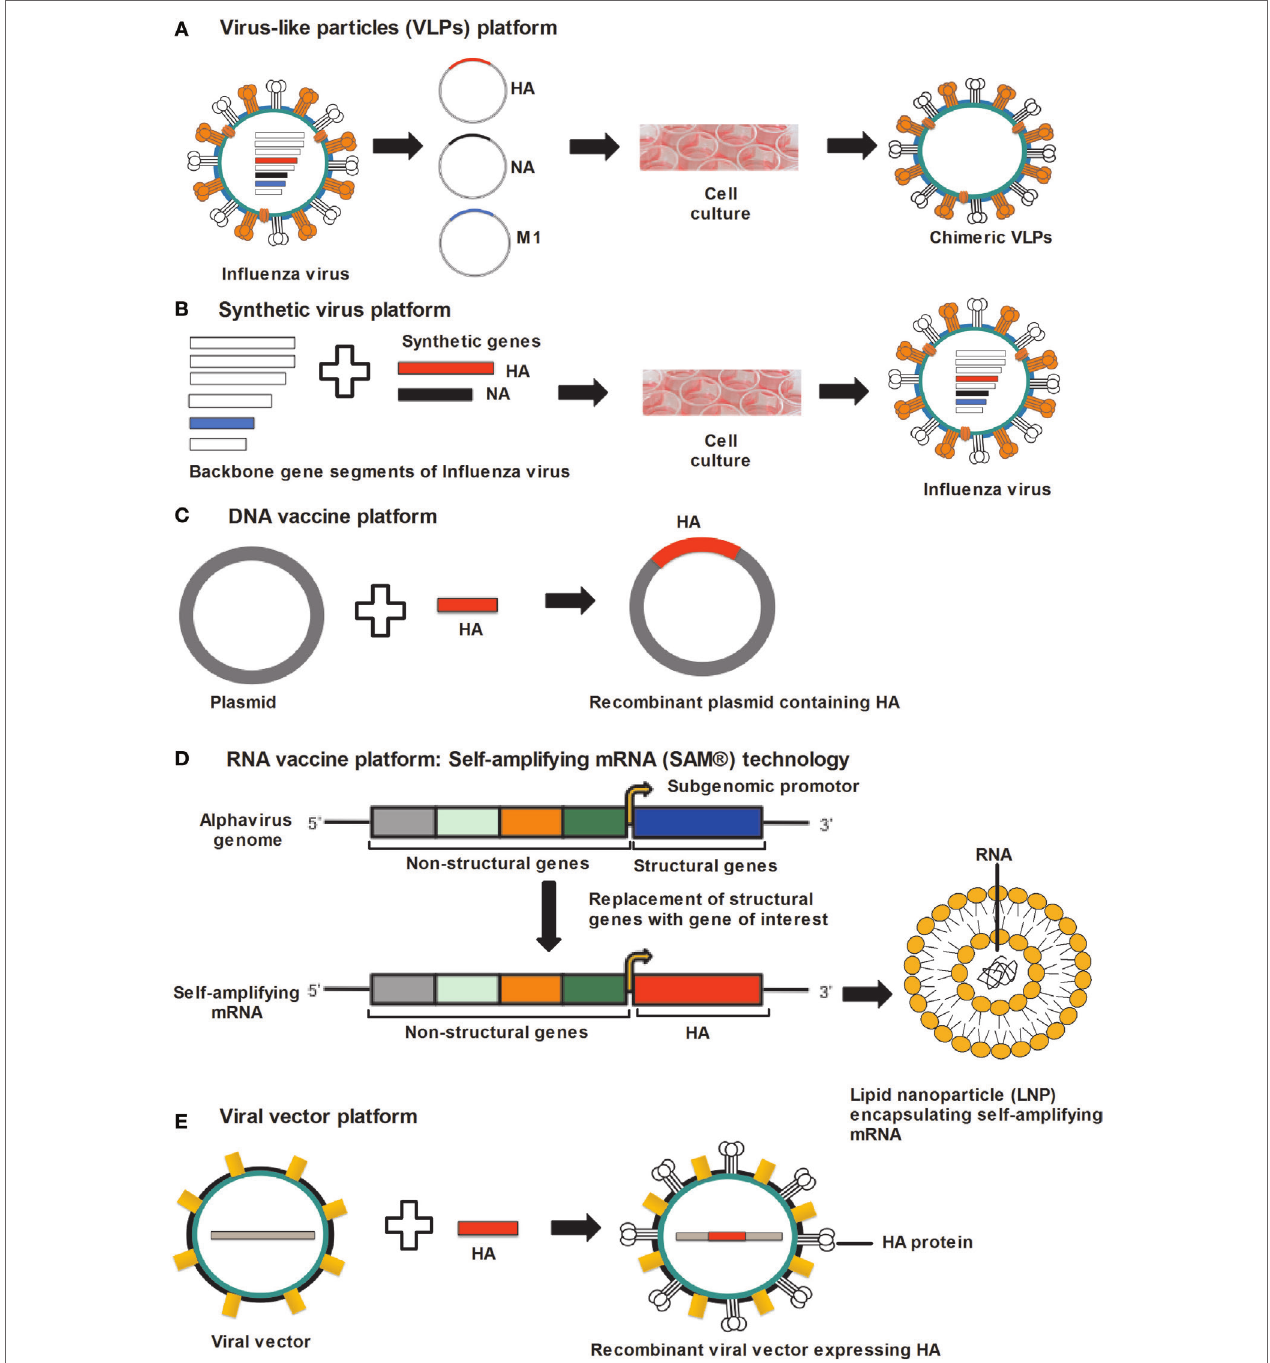
FiGURe 1 | Approaches for universal influenza vaccine development. (A) VLP platform: VLPs produced by cloning of HA, NA, and M1 gene sequences of influenza virus into the expression vector followed by transfection in to insect cells. Co-expression of HA, NA, and M1 proteins allows self-assembly of VLPs. (B) Synthetic-virus platform: MDCK cells are transfected with plasmid DNA encoding influenza-virus backbone genes and error-free HA and NA gene segments, synthesized by an enzymatic and cell-free assembly technique. After transfection, vaccine viruses are rescued from MDCK cells. (C) DNA-vaccine platform: influenza genes encoding antigenic proteins are inserted into a DNA plasmid and delivered to the host cells, where DNA vaccines express antigenic protein. (D) RNA-vaccine platform: self-amplifying RNA expressed from an alphavirus genome in which structural genes are replaced by genes supporting the amplification of the RNA and the gene encoding the antigen. Self-amplifying mRNA (SAM) composed of a 5 ′ cap, genes encoding non-structural genes (NSP 1–4), a subgenomic promoter, the antigen- encoding gene, and a 3 ′ poly(A) tail. Diagrammatic representation of a lipid nanoparticle (LNP) encapsulating SAM. (e) Viral-vector platform: viral vector-based influenza vaccine uses a non-influenza “carrier” virus to express antigenic protein. Influenza genes encoding HA protein are placed in to the carrier virus vector to express HA protein on the virus surface. Abbreviations: HA, hemagglutinin; NA, neuraminidase; M1, matrix protein 1; VLP, virus-like particle; MDCK, Madin–Darby kidney cells.